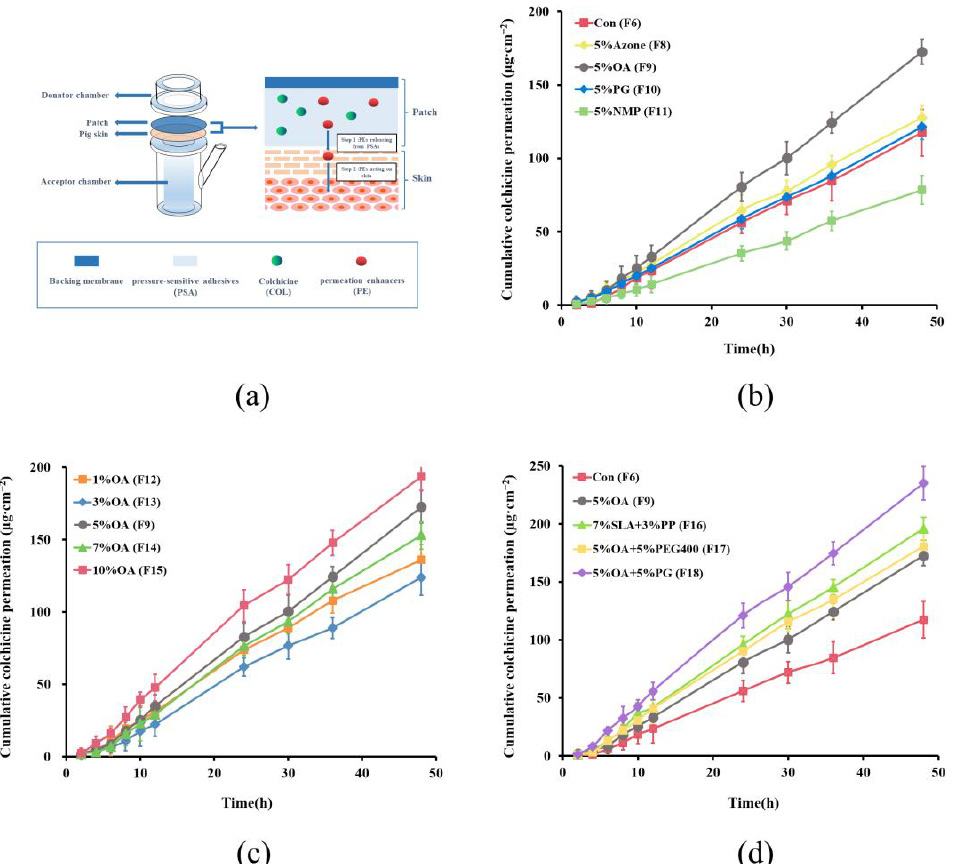
Figure 3. ( a ) The schematic diagram of screening device of the permeation enhancers and its action on the skin. In vitro pig skin permeation profiles of colchicine from patches containing 10% drug with ( b ) different single permeation enhancers, ( c ) different concentrations of oleic acid (OA), ( d ) binary permeation enhancers in Duro-Tak 87-2516 (mean ± SD, n = 6). All the concentration values were calculated ( w / w %) based on the dry weight of